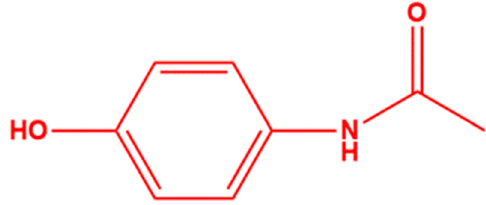
Figure 2. Paracetamol (PTM) molecule.